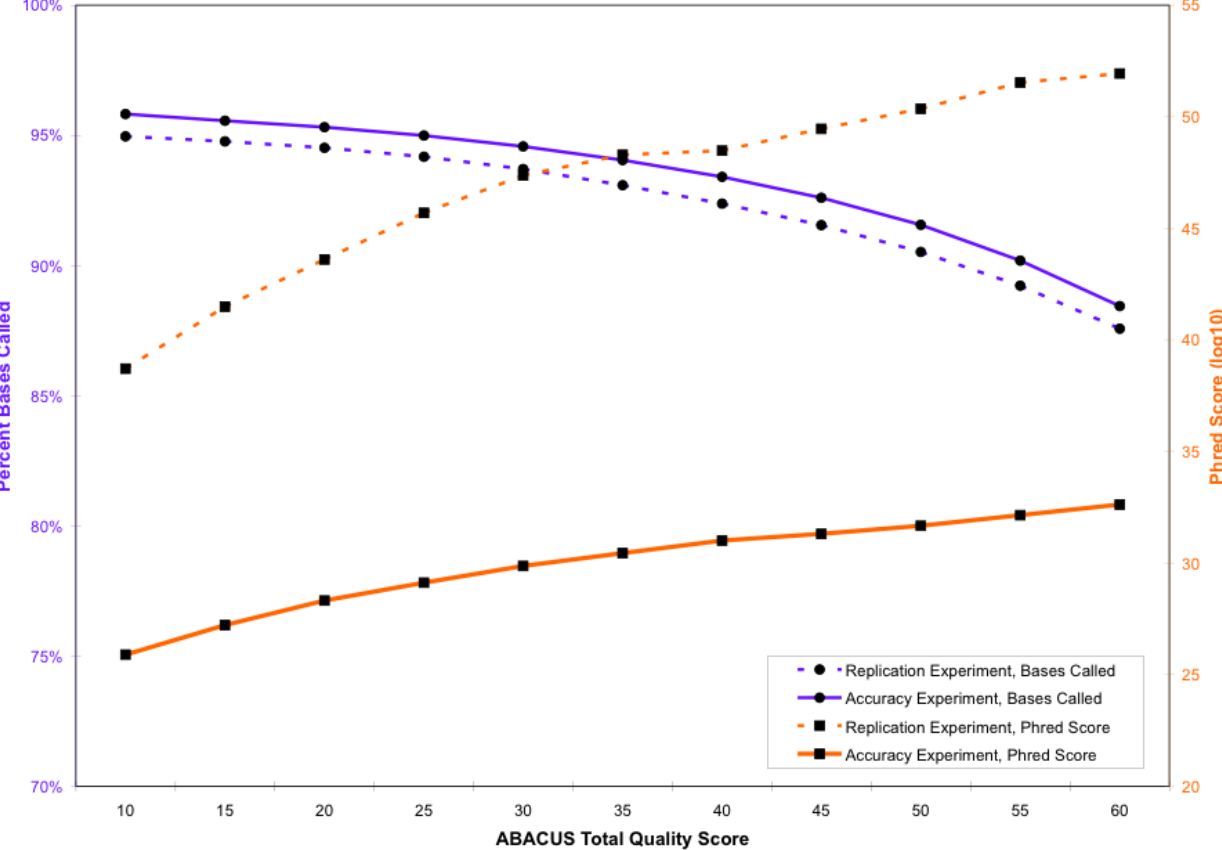
Figure 1. Graph shows the relationship between basecalling frequency and estimated phred score at various ABACUS total quality score thresholds. For both the replication and accuracy experiments in Zwick et al. (2005), note that as the ABACUS total quality score threshold is increased, the number of bases called is decreased, with a concomitant increase in data quality (phred score).